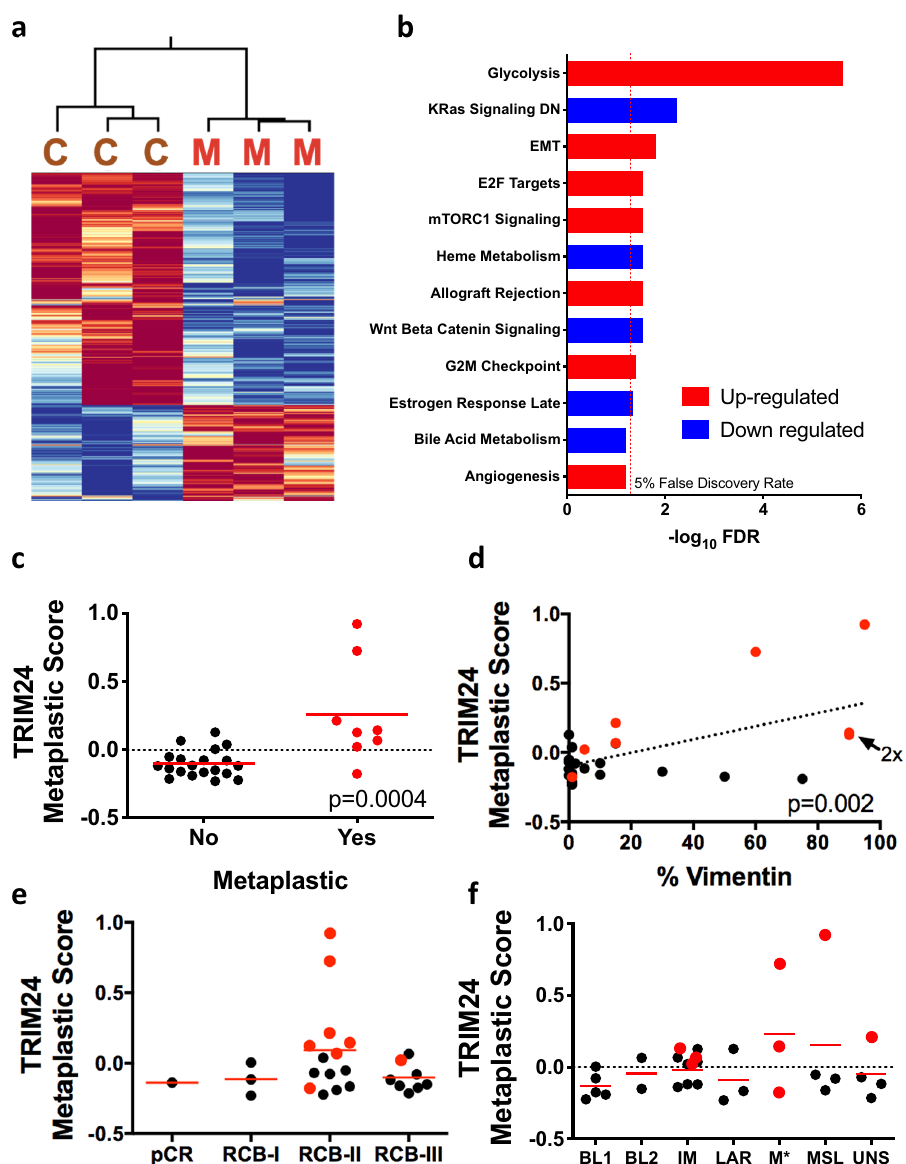
Fig. 6 A murine TRIM24 metaplastic carcinosarcoma gene signature correlates with human TNBC MpBC patient signature, EMT, and chemorefractory mesenchymal subtype. a Heatmap of expression of genes from the TRIM24 signature in Trim24 COE tumors and human metaplastic TNBCs. C - Trim24 COE carcinomas and M - Trim24 COE metaplastic carcinosarcomas. b Statistical signi fi cance of Hallmark pathways most strongly enriched in the TRIM24 signature. Red: up in TRIM24, Blue: down in TRIM24. The dotted line represents FDR < 0.05 threshold. c TRIM24 metaplastic score matched to MpBC patient gene expression (red) compared to non-MpBC TNBC patient gene expression (black). d Correlation of percentage of Vimentin staining in patient biopsies from the ARTEMIS TNBC cohort. MpBC tumors are in red. e Association of TRIM24 scores with response to primary chemotherapy in TNBC and MpBC patients from the ARTEMIS trial. pCR: pathological complete response, RCB-I-III – residual cancer burden categories 1 – 3. MpBC patients are shown in red. f Distribution and classi fi cation of the ARTEMIS patient cohort and their correlation with TRIM24 metaplastic score to various subtypes of TNBC. BL basal like, IM immunomodulatory, LAR luminal androgen receptor, M* mesenchymal, MSL mesenchymal stem-like, UNS unstable tumor type. Data represented as mean in c – e and p -values are calculated based on two-tailed unpaired t